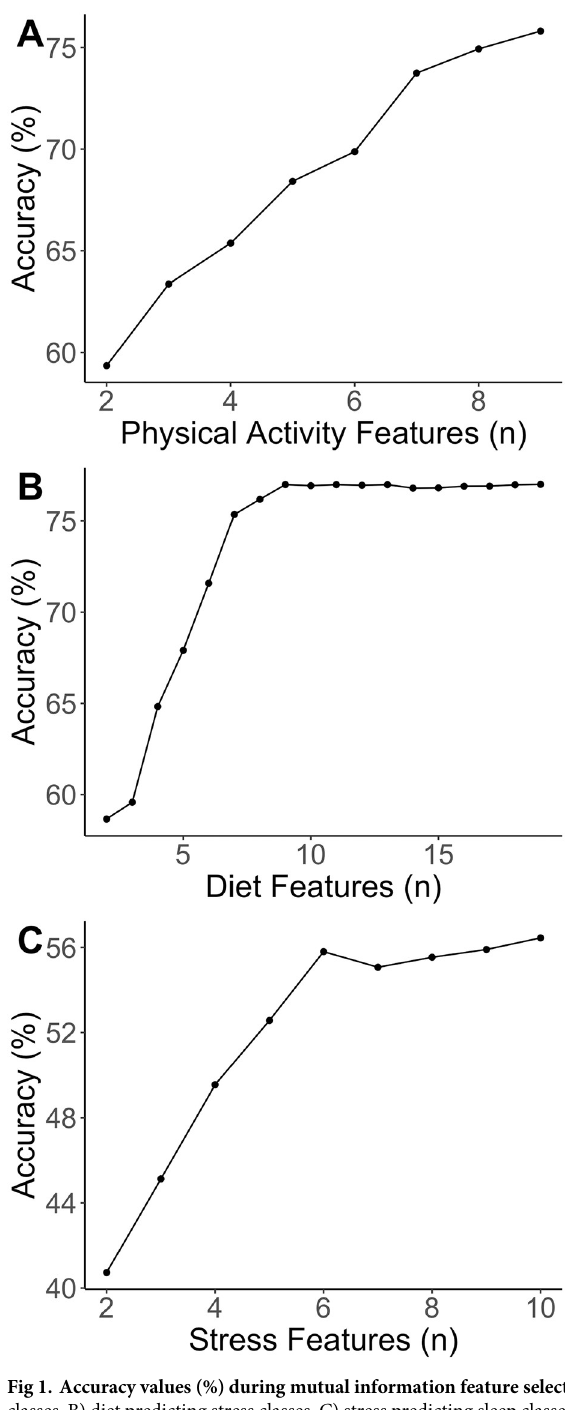
Fig 1. Accuracy values (%) during mutual information feature selection. A) physical activity predicting stress classes, B) diet predicting stress classes, C) stress predicting sleep classes.